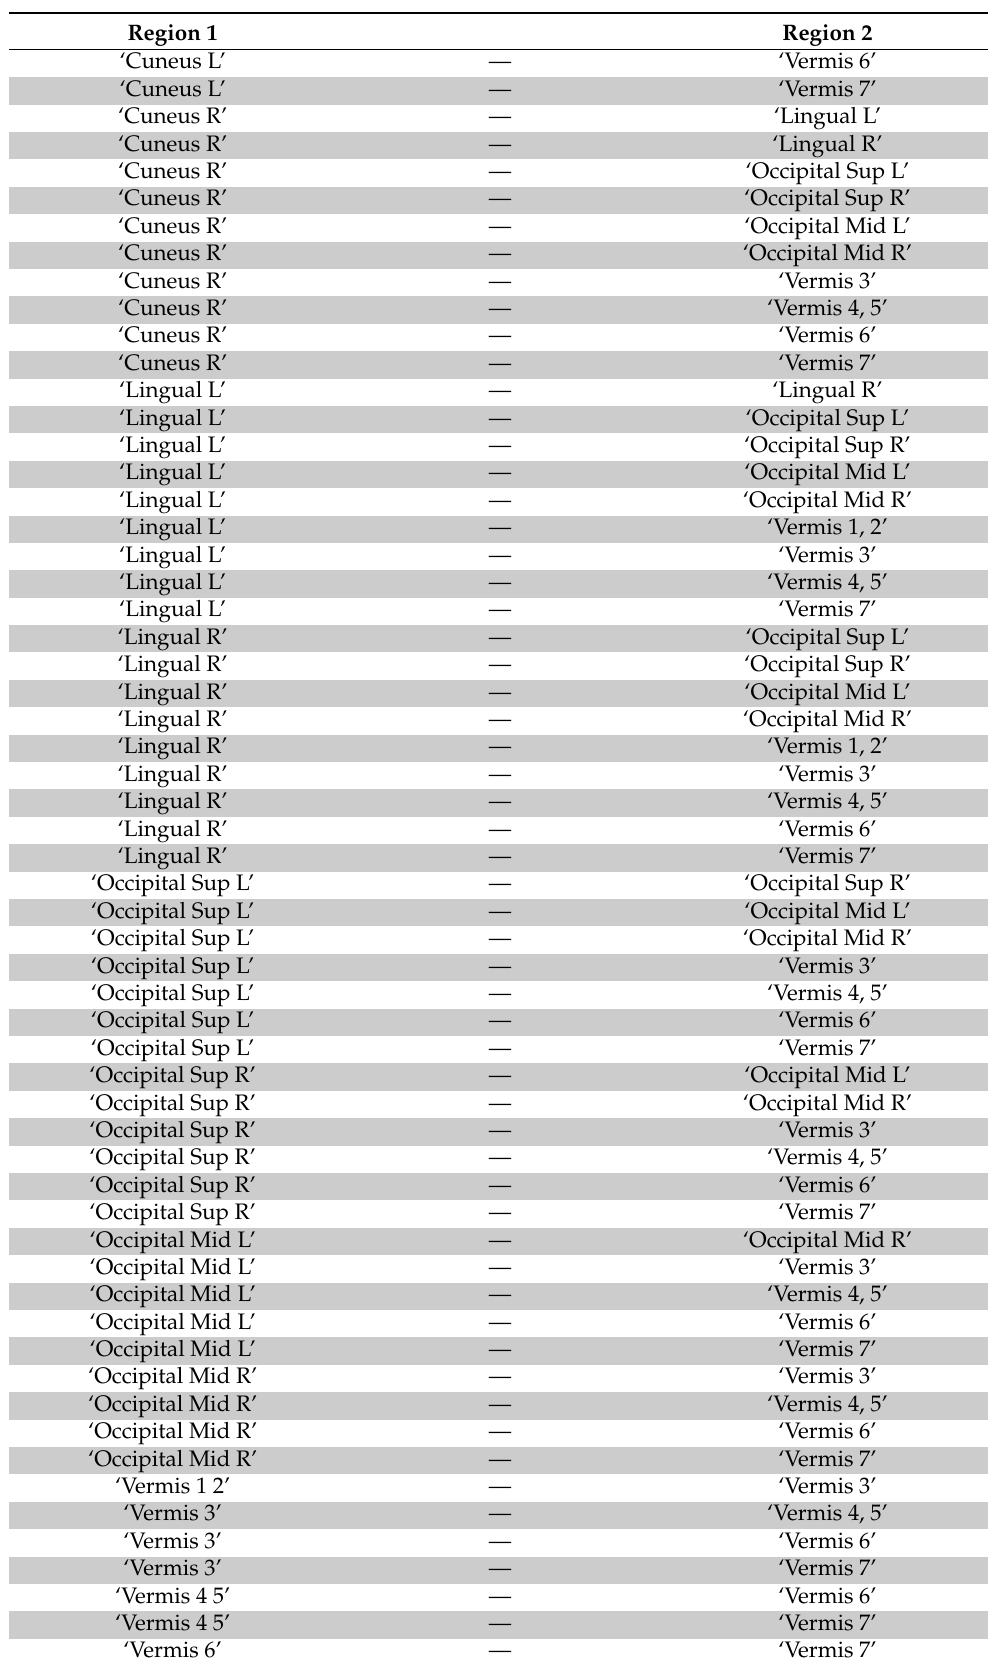
Table A1. Cont. Region 1 Region 2 ‘Cuneus L’ — ‘Vermis 6’ ‘Cuneus L’ — ‘Vermis 7’ ‘Cuneus R’ — ‘Lingual L’ ‘Cuneus R’ — ‘Lingual R’ ‘Cuneus R’ — ‘Occipital Sup L’ ‘Cuneus R’ — ‘Occipital Sup R’ ‘Cuneus R’ — ‘Occipital Mid L’ ‘Cuneus R’ — ‘Occipital Mid R’ ‘Cuneus R’ — ‘Vermis 3’ ‘Cuneus R’ — ‘Vermis 4, 5’ ‘Cuneus R’ — ‘Vermis 6’ ‘Cuneus R’ — ‘Vermis 7’ ‘Lingual L’ — ‘Lingual R’ ‘Lingual L’ — ‘Occipital Sup L’ ‘Lingual L’ — ‘Occipital Sup R’ ‘Lingual L’ — ‘Occipital Mid L’ ‘Lingual L’ — ‘Occipital Mid R’ ‘Lingual L’ — ‘Vermis 1, 2’ ‘Lingual L’ — ‘Vermis 3’ ‘Lingual L’ — ‘Vermis 4, 5’ ‘Lingual L’ — ‘Vermis 7’ ‘Lingual R’ — ‘Occipital Sup L’ ‘Lingual R’ — ‘Occipital Sup R’ ‘Lingual R’ — ‘Occipital Mid L’ ‘Lingual R’ — ‘Occipital Mid R’ ‘Lingual R’ — ‘Vermis 1, 2’ ‘Lingual R’ — ‘Vermis 3’ ‘Lingual R’ — ‘Vermis 4, 5’ ‘Lingual R’ — ‘Vermis 6’ ‘Lingual R’ — ‘Vermis 7’ ‘Occipital Sup L’ — ‘Occipital Sup R’ ‘Occipital Sup L’ — ‘Occipital Mid L’ ‘Occipital Sup L’ — ‘Occipital Mid R’ ‘Occipital Sup L’ — ‘Vermis 3’ ‘Occipital Sup L’ — ‘Vermis 4, 5’ ‘Occipital Sup L’ — ‘Vermis 6’ ‘Occipital Sup L’ — ‘Vermis 7’ ‘Occipital Sup R’ — ‘Occipital Mid L’ ‘Occipital Sup R’ — ‘Occipital Mid R’ ‘Occipital Sup R’ — ‘Vermis 3’ ‘Occipital Sup R’ — ‘Vermis 4, 5’ ‘Occipital Sup R’ — ‘Vermis 6’ ‘Occipital Sup R’ — ‘Vermis 7’ ‘Occipital Mid L’ — ‘Occipital Mid R’ ‘Occipital Mid L’ — ‘Vermis 3’ ‘Occipital Mid L’ — ‘Vermis 4, 5’ ‘Occipital Mid L’ — ‘Vermis 6’ ‘Occipital Mid L’ — ‘Vermis 7’ ‘Occipital Mid R’ — ‘Vermis 3’ ‘Occipital Mid R’ — ‘Vermis 4, 5’ ‘Occipital Mid R’ — ‘Vermis 6’ ‘Occipital Mid R’ — ‘Vermis 7’ ‘Vermis 1 2’ — ‘Vermis 3’ ‘Vermis 3’ — ‘Vermis 4, 5’ ‘Vermis 3’ — ‘Vermis 6’ ‘Vermis 3’ — ‘Vermis 7’ ‘Vermis 4 5’ — ‘Vermis 6’ ‘Vermis 4 5’ — ‘Vermis 7’ ‘Vermis 6’ — ‘Vermis